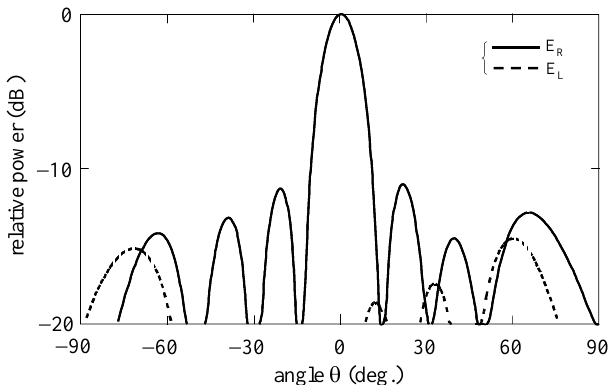
Figure 6. Simulated radiation pattern in φ = 0 ◦ plane for a branched line antenna with N = 4.